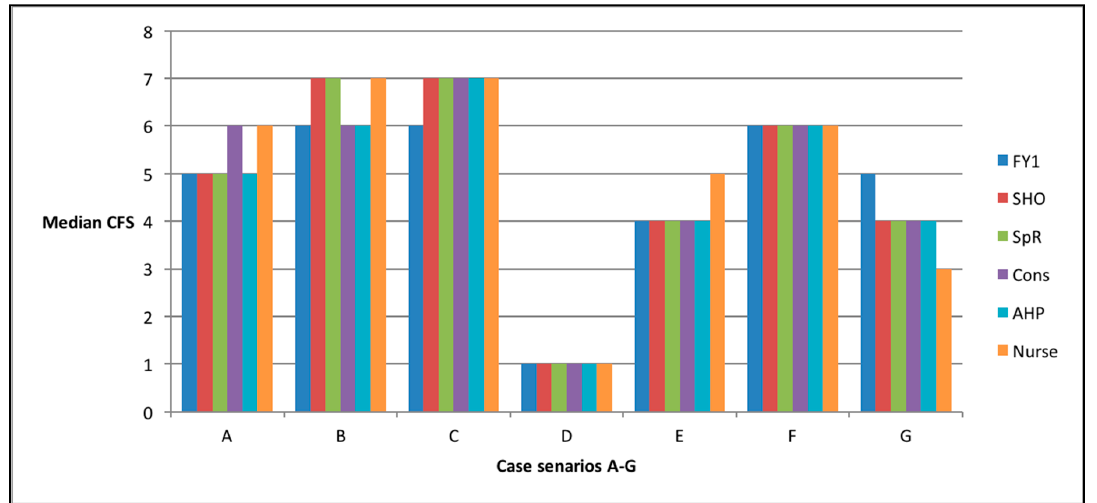
Figure 2. Distribution of staff completing the study.